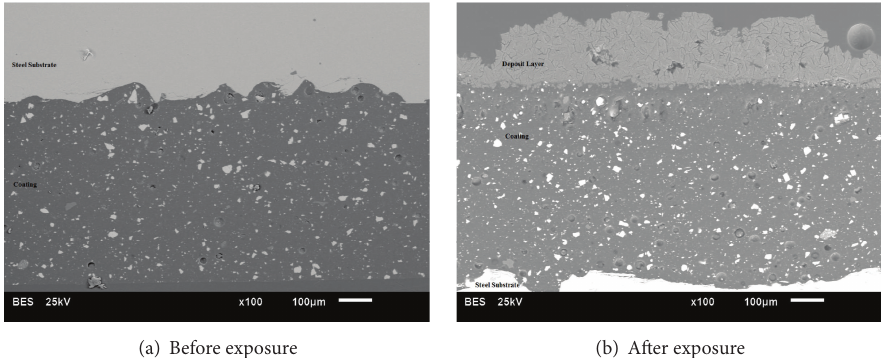
Figure 2: SEM cross section analysis of Fusion Bond Epoxy coating: (a) before and (b) after exposure to 5% NaOH solution for 30 days at 93 ∘ C/200 ∘ F.